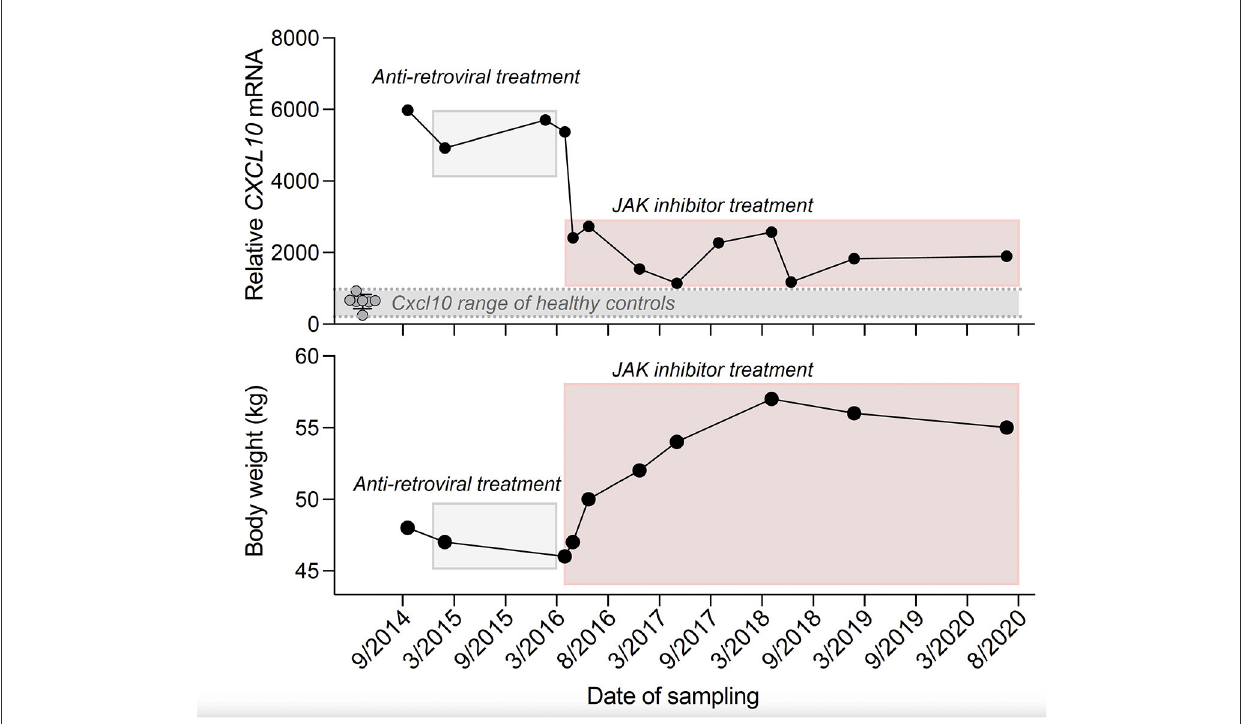
FIGURE2 Time course of CXCL10 mRNA transcript expression in PBMCs of the index patient and eight age- and sex-matched healthy controls (Top) and body weight of the index patient (Bottom) . RT-PCR results were normalized to TATA-binding-protein (Top) . Anti-retroviral treatment: Emtricitabine (200mg per day), Tenofovir disoproxil fumarate (245mg per day), Nevirapine (400mg per day) and JAK inhibitor treatment: Ruxolitinib (10–25mg per day). *In 09/2014 the patient was not taking any immunosuppressive